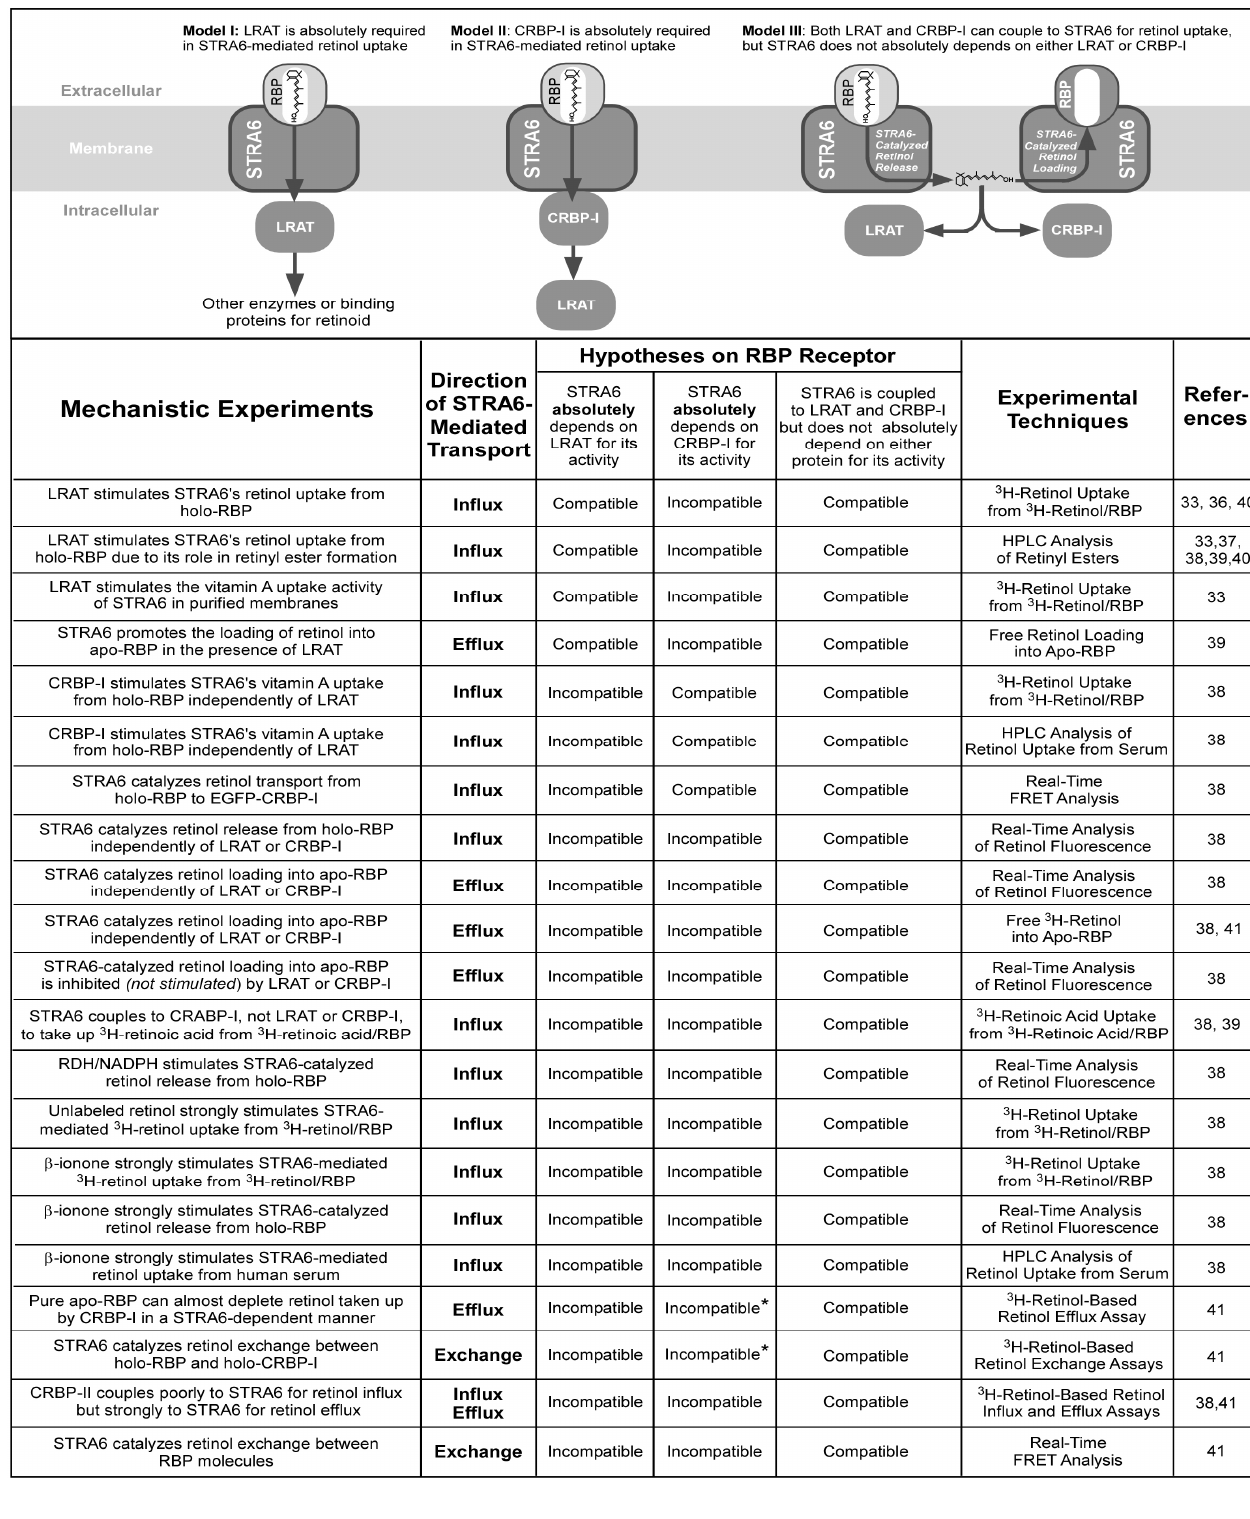
Figure 3. Major hypotheses on the mechanism of STRA6-mediated cellular vitamin A uptake from holo-RBP and experimental evidence that is compatible or incompatible with these hypotheses. Evidence revealed by diverse mechanistic experiments argues against the absolute dependence of STRA6 on either LRAT or CRBP-I. In the STRA6 activities marked by asterisks, STRA6 catalyzes the removal of retinol from CRBP-I. These activities are also incompatible with models that proposed the absolute requirement of CRBP-I for STRA6’s activity because these models also proposed that only apo-CRBP-I interacts with